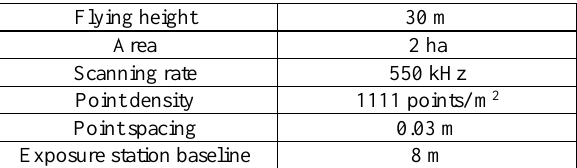
Table 2: Summary of the laser scanning mission.